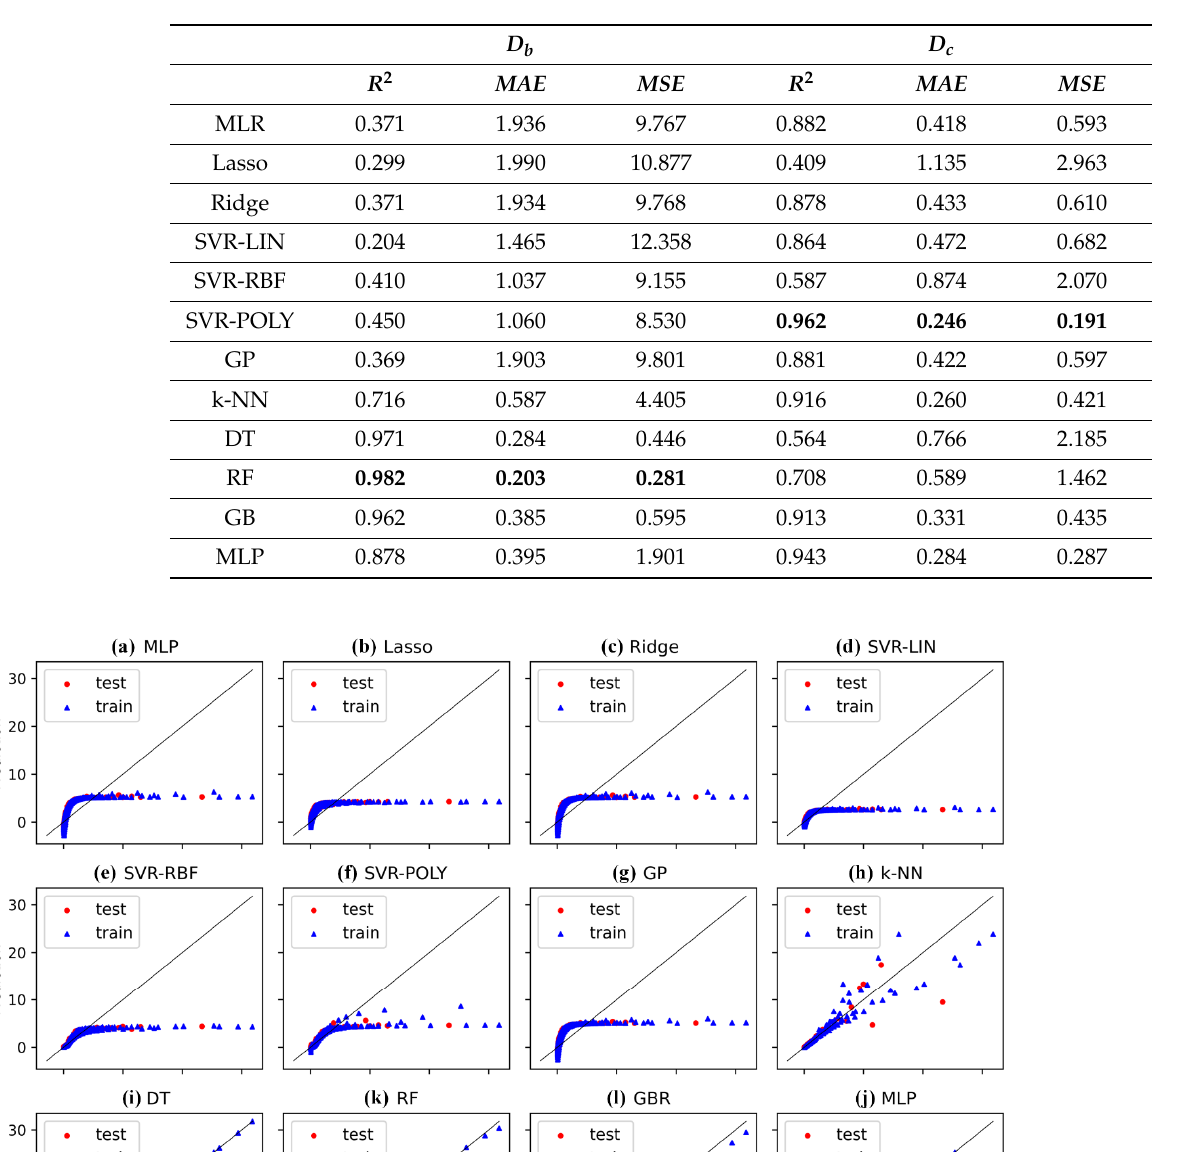
Table 1. Metrics and comparison of 12 ML algorithms for the datasets corresponding to simulation indicate the best metrics achieved for each dataset.